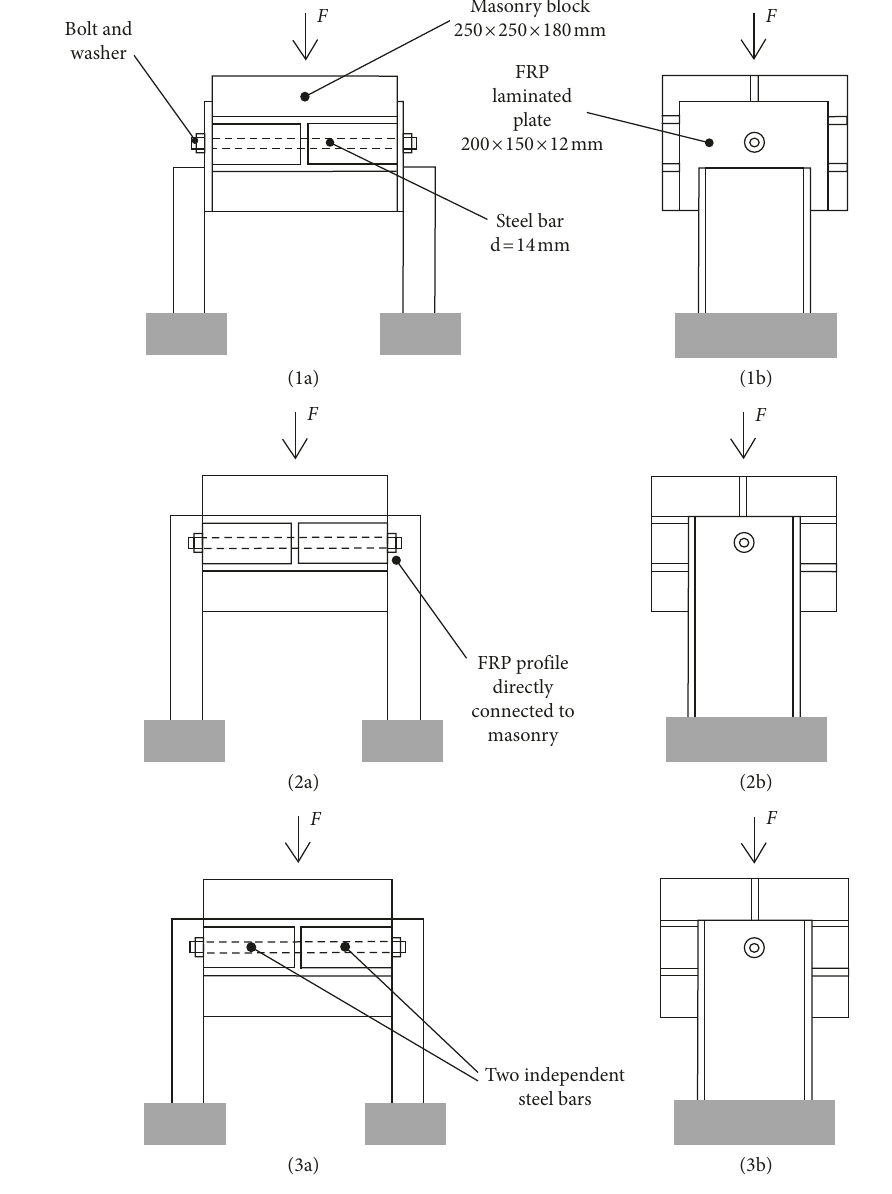
Figure 3: Different joint configurations tested. Table 2: Material